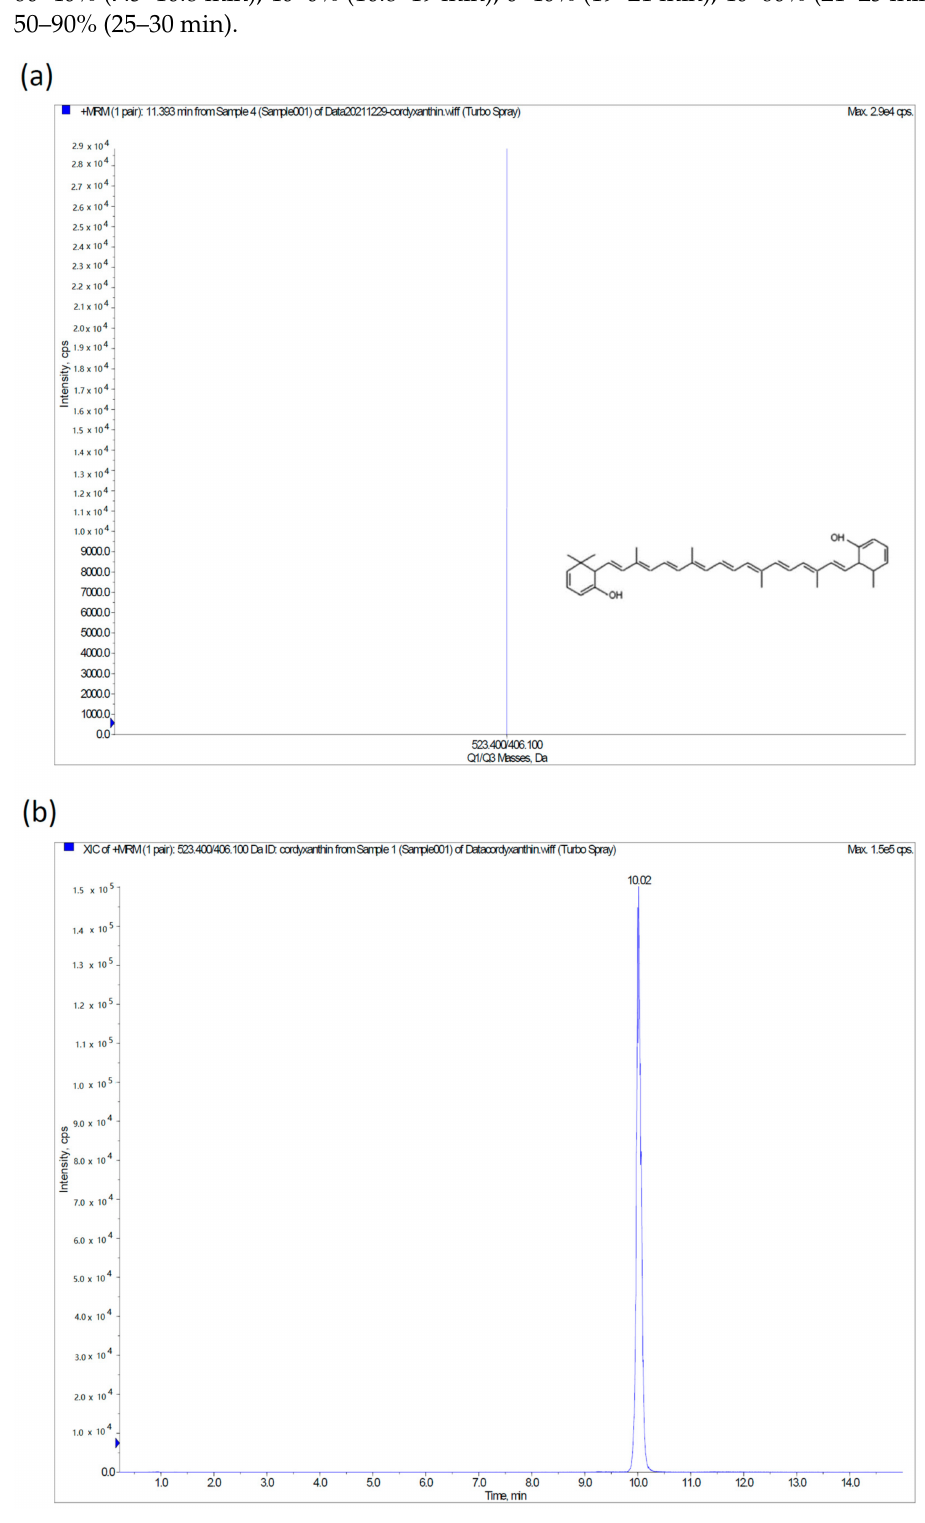
Figure 1. High-performance liquid chromatography-electrospray ionization mass spectrometry analysis of cordyxanthin, a water-soluble carotenoid, in C. militaris extract. ( a ) ESI source of the mass spectrometer; cordyxanthin-III showed good sensitivity in the positive ion mode; ( b ) MRM chromatographic profiles of the cordyxanthin from C. militaris